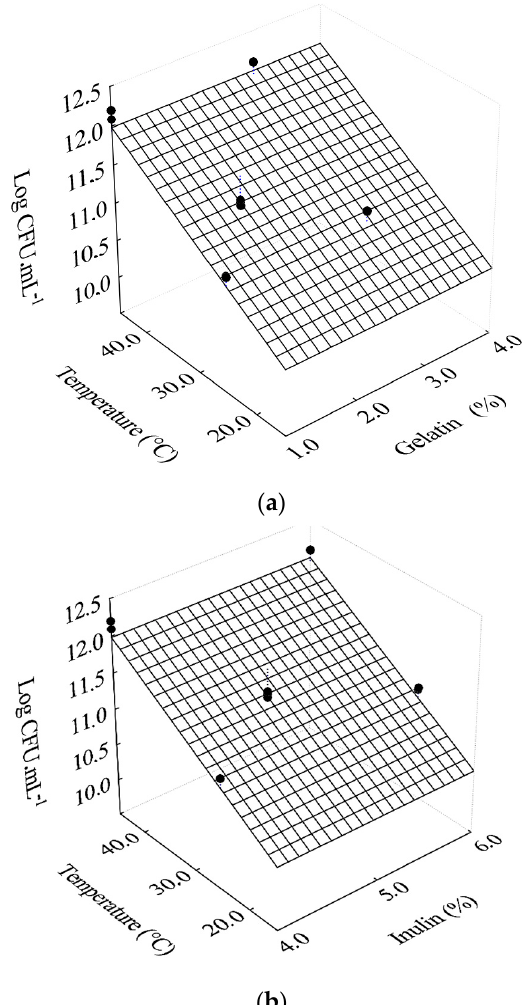
Figure 1. Response surfaces for the effects of temperature as a function of gelatin concentration ( a ) and inulin concentration ( b ) on cell concentration.